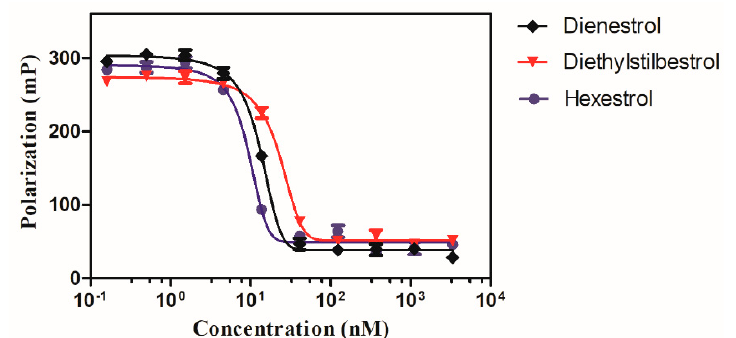
Figure 1. Competitive binding of the tested compounds to estrogen receptor α ligand binding domain (ER-LBD).